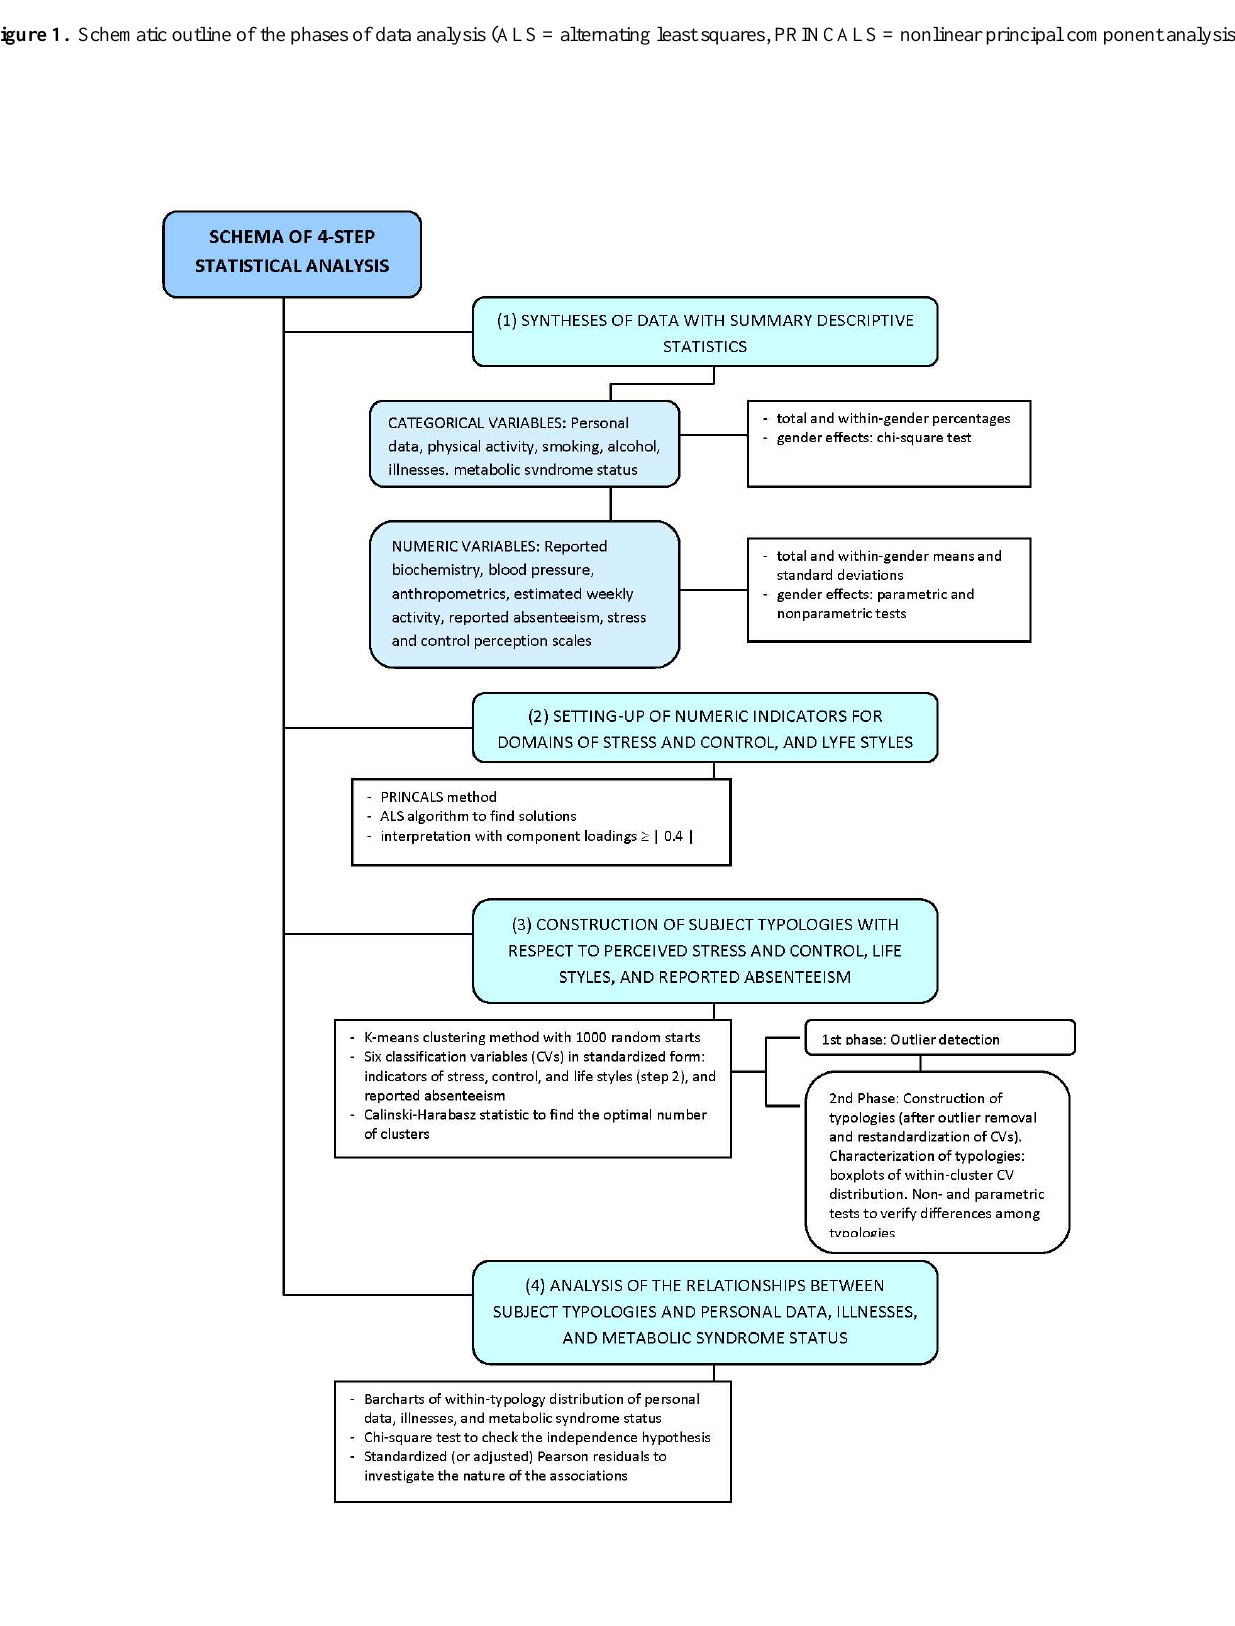
Figure 1. Schematic outline of the phases of data analysis (ALS = alternating least squares, PRINCALS = nonlinear principal component